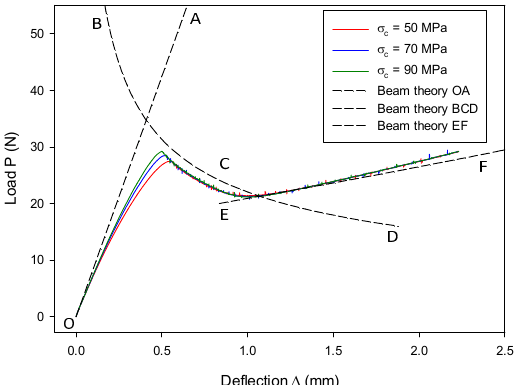
Figure 23. End load P as a function of deflection ∆ in the MMB model ( β (cid:3404) 20%) with different cohesive strengths.